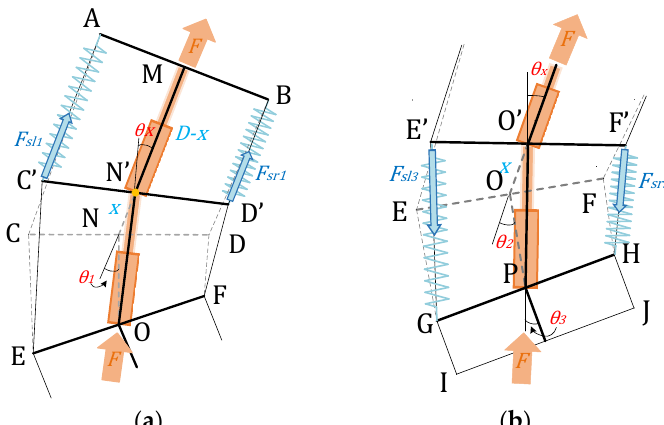
Figure 17. ( a ) A brief diagram of the force in Segment 2 at a certain point during Phase 2; ( b ) a brief diagram of the force in Segment 3 at a certain point during Phase 3. The dotted line in the diagram is the initial position before the movement.